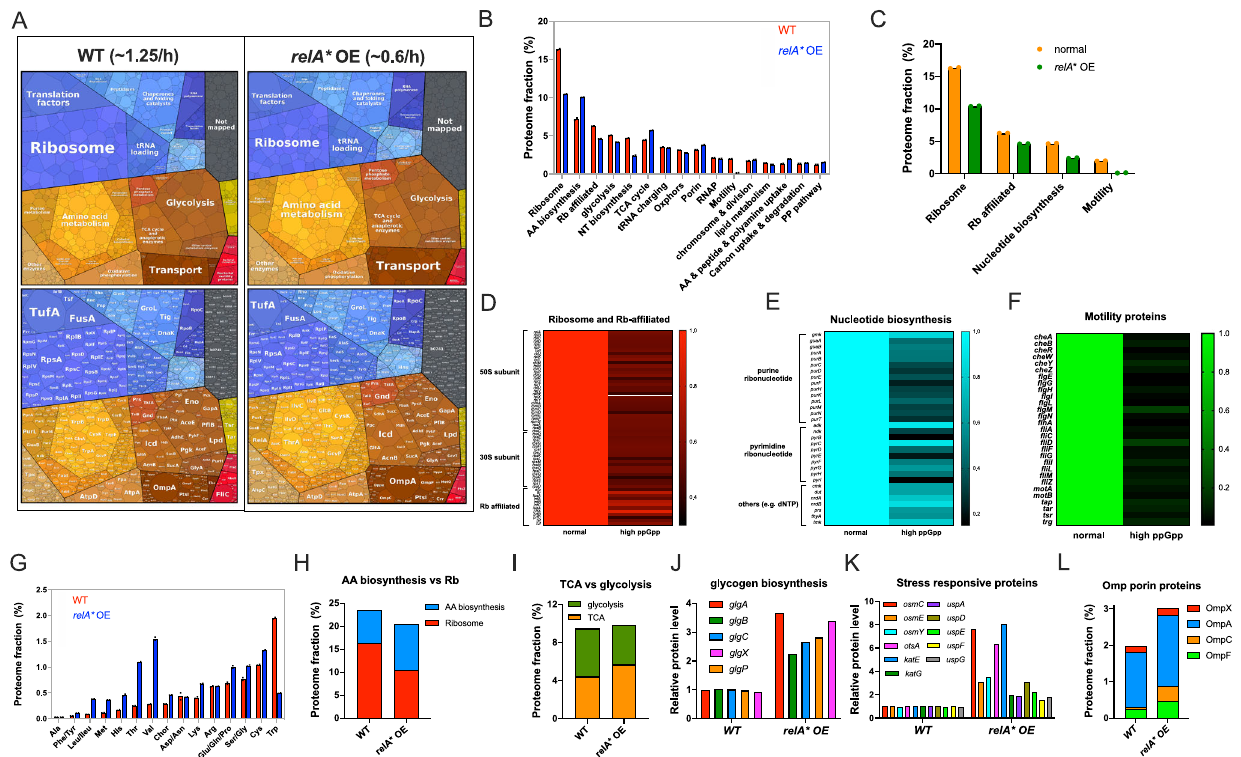
Fig.3|Globaleffectof(p)ppGpponproteomeresourceallocationof E.coli . The proteome abundances of wild type strain (WT) and E. coli RelA* OE strain (pLAS13- relA *) during exponential growth in glucose cAA medium were investigated by 4D label-free mass spectrometry. Proteome fraction data are obtained from iBAQ intensity while relative abundances of individual proteins are based on LFQ inten- sity.Themediumof E.coli RelA*OEstrainwassupplementedwith30 µ MIPTG.This condition is thus referred to as “ relA * OE ” or “ high ppGpp ” . A Proteome resource allocation of E. coli analyzed by proteomaps. The proteome of E. coli was divided into various functional groups by proteomaps website based on KEGG classi fi